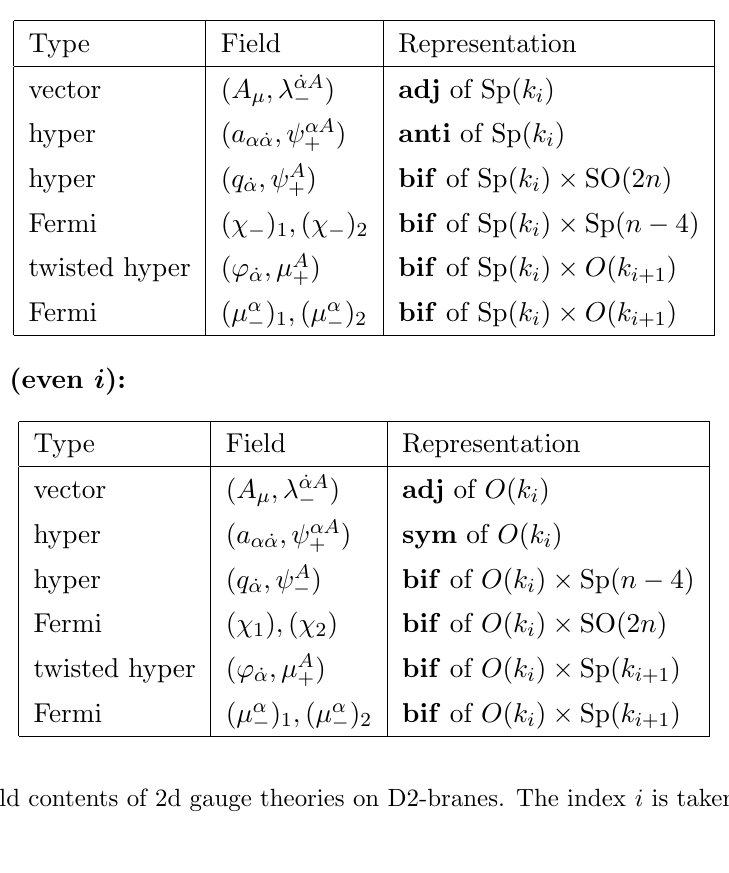
are i =1 ; (cid:1)(cid:1)(cid:1) ;r i